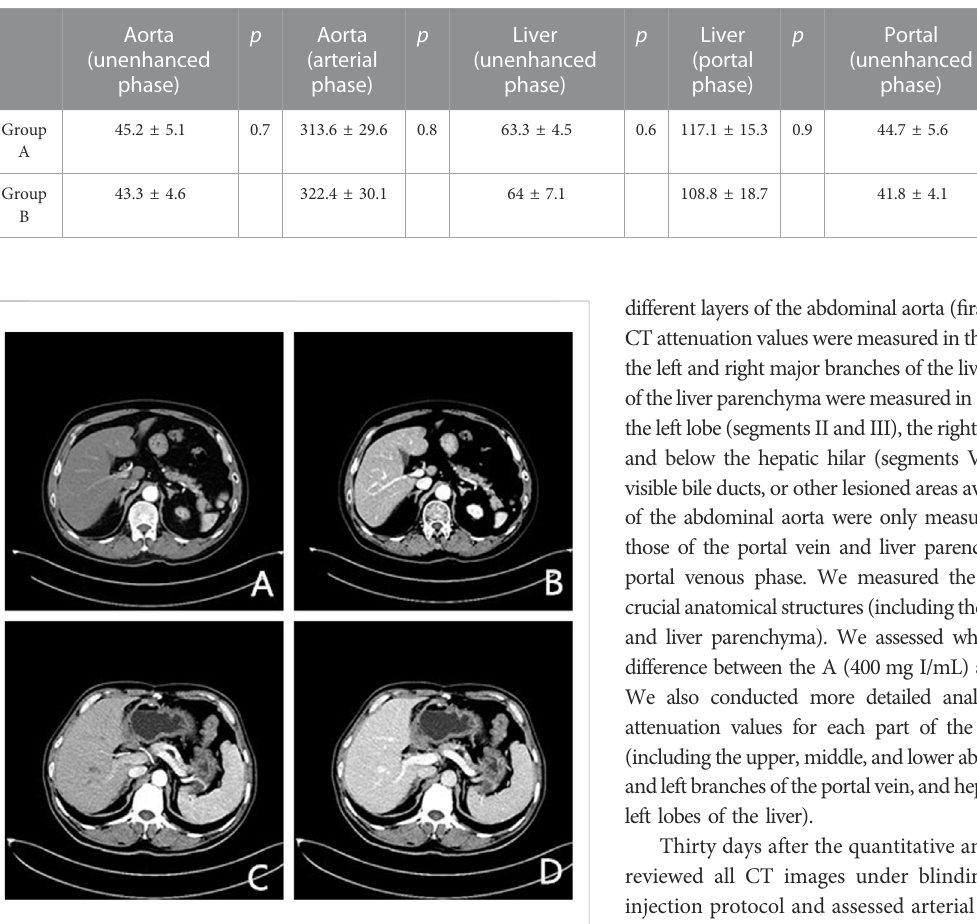
FIGURE 1 Axial enhanced CT images of two patients (arterial and venous phase). (A) , (B) a 56-year-old man with lung cancer after chemotherapy (400 mg I/ml); (C) , (D) a 64-year-old man after resection of gastric cancer (300 mg